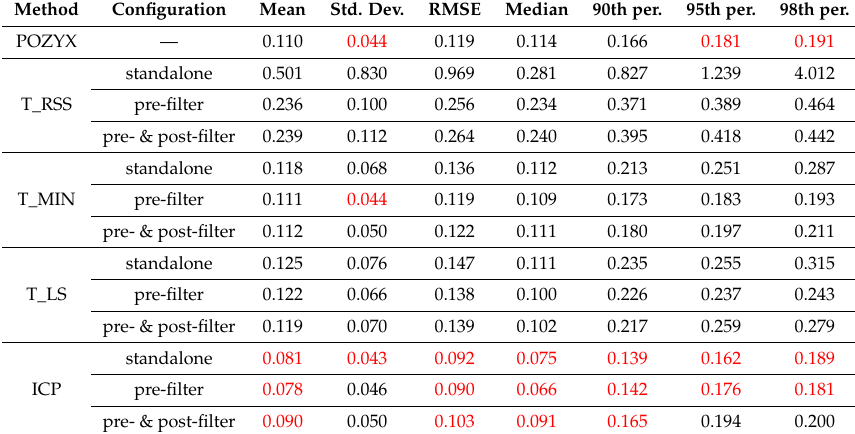
Table 3. Performance data for the figure-eight-like trajectory. Values in red denote the three best values for each metric. All values are in meters.